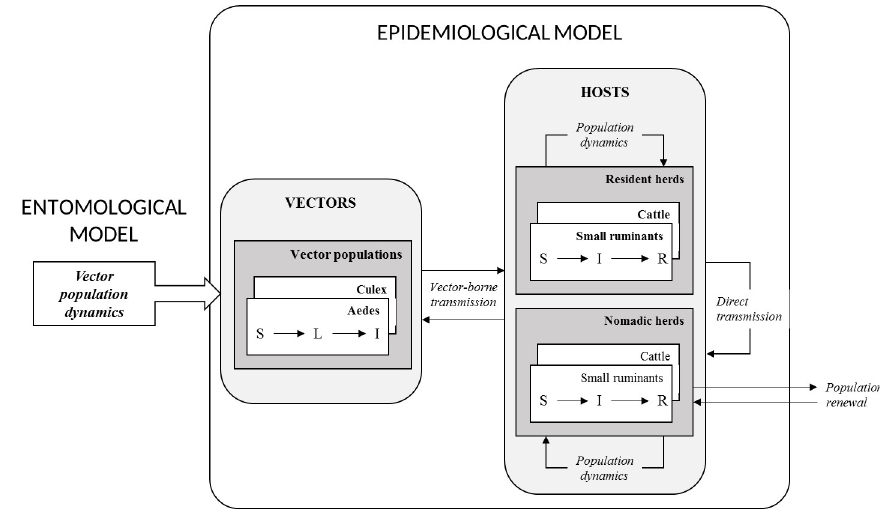
Fig 2. Schematic representation of the epidemiological